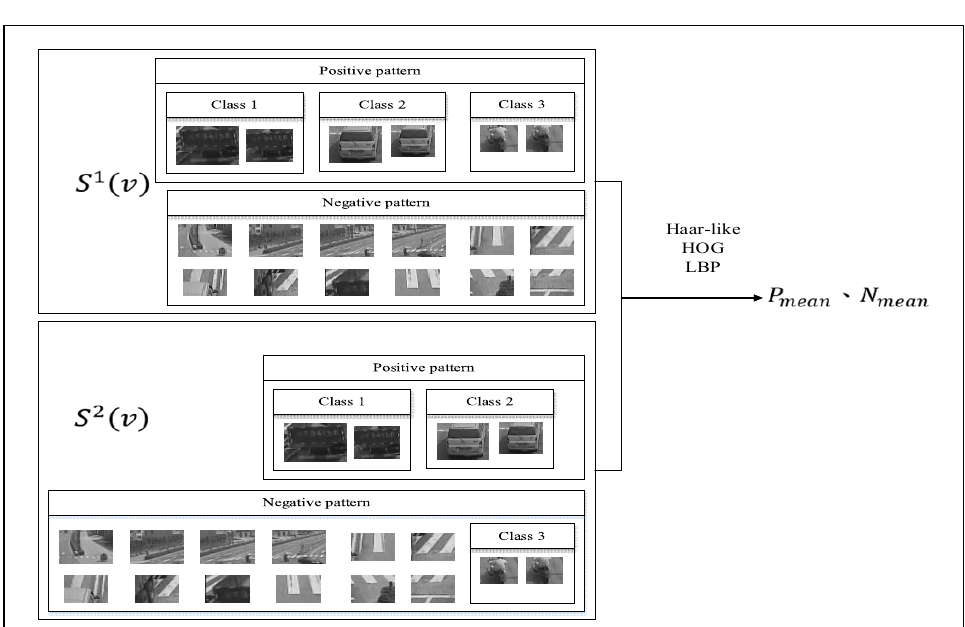
Figure 9. Calculation of response value.